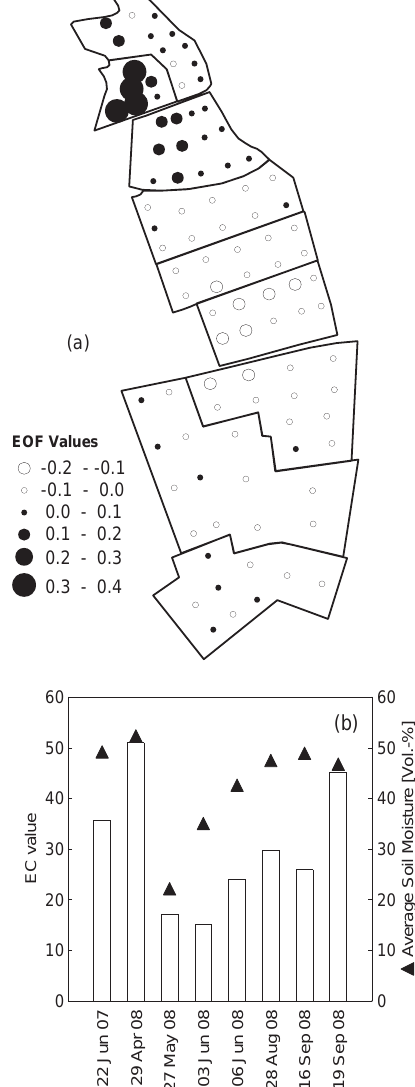
Figure 5. EOF1 (a) and EC1 (b) patterns of the Fig. 5. EOF1 (a) and EC1 (b) patterns of the spatial analysis in spatial analysis in the grassland test site; the the grassland test site; the triangles in (b) represent the average soil triangles in (b) represent the average soil moisture on the different moisture on the different days.